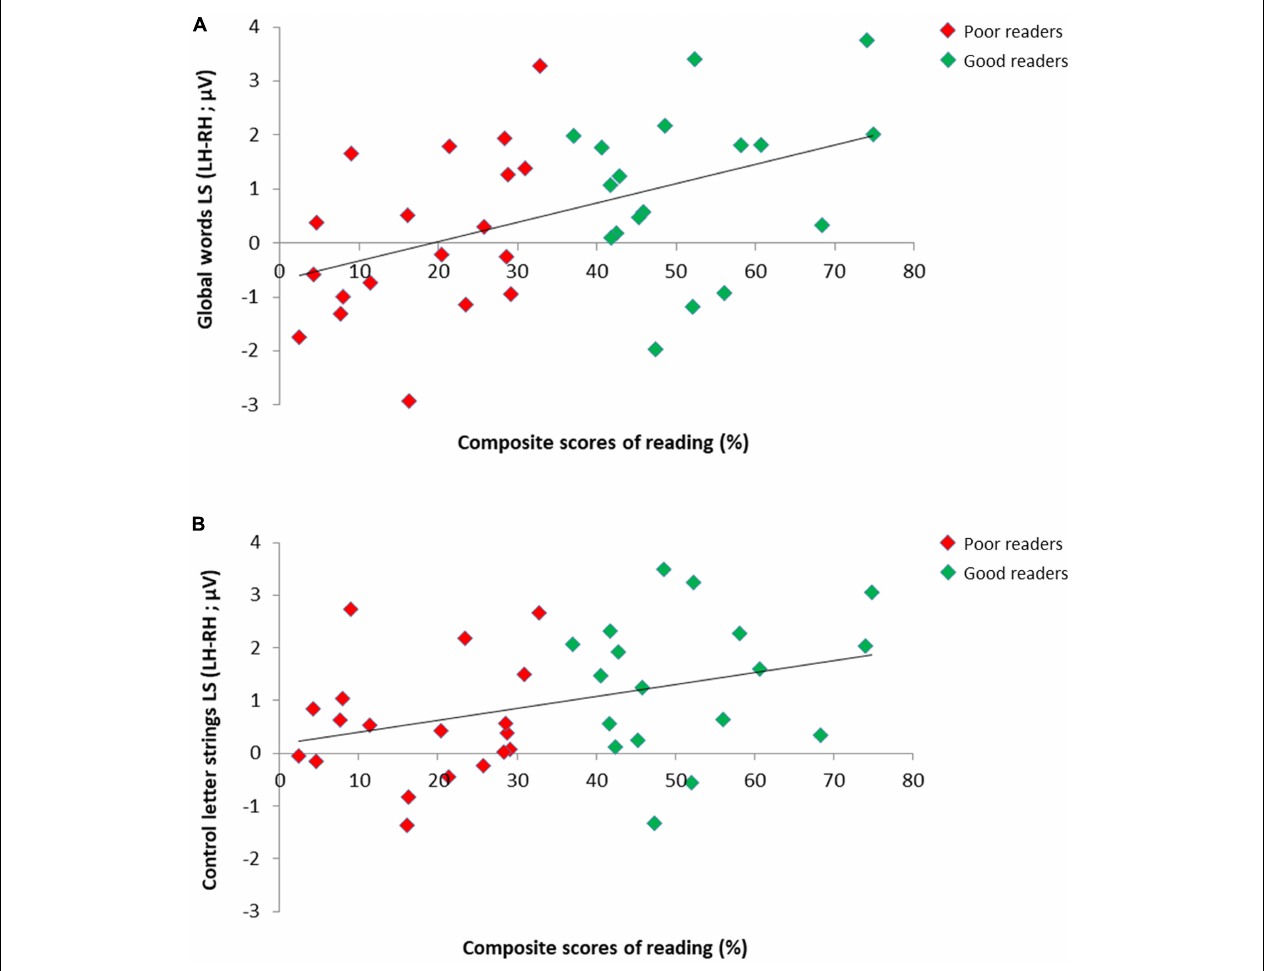
FIGURE 4 | Relation between individual reading scores and EEG lateralization scores for the responses to letter strings in 37 children. Scatter plots of significant positive correlation between composite scores of reading (averaged accuracy scores for single letters, syllables, pseudowords and words) and EEG lateralization scores (LH-RH) for the responses to (A) global words (Spearman Rho = 0.44) and (B) control letter strings (averaged response to control words/pseudowords; Spearman Rho = 0.36) in good readers ( N = 18; green dots) and poor readers ( N = 19; red